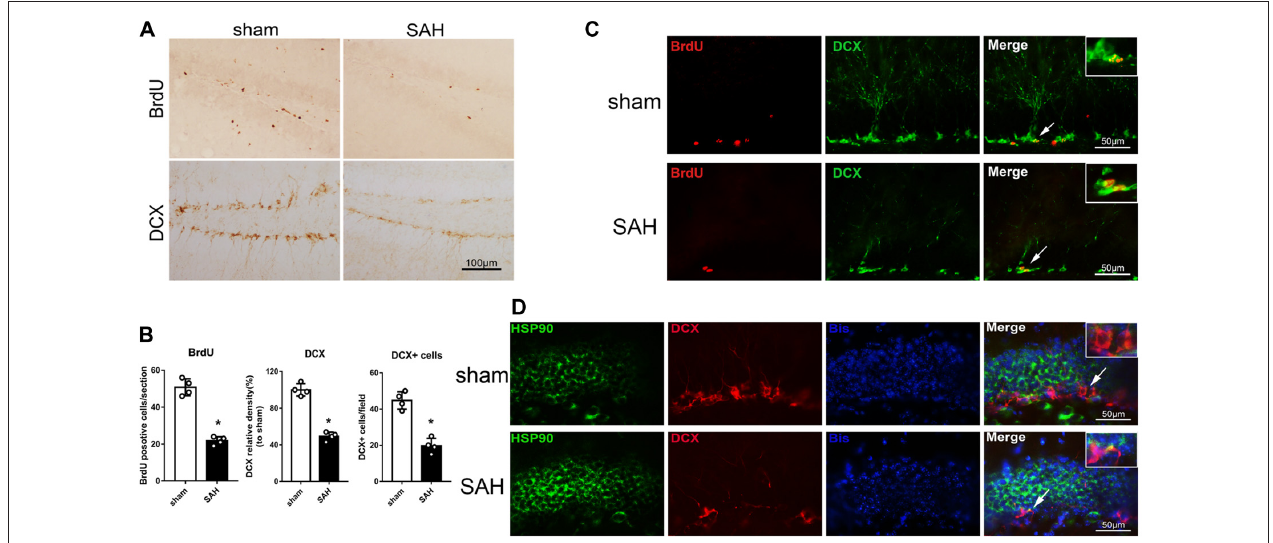
FIGURE 2 | Expression of doublecortin (DCX) and 5-bromo-2’-deoxyuridine (BrdU) incorporation after SAH. (A) Immunohistochemistry staining and (B) quantitative analyses of BrdU and DCX in the left hippocampus in sham and SAH groups at 48 h. (C) Double immunofluorescence staining for BrdU (red) and DCX (green) in the left hippocampus 48 h after surgery. (D) Double immunofluorescence staining for HSP90 (green) and DCX (red) in the left hippocampus at 48 h after surgery; n = 4 per group. ∗ P < 0.05 vs. sham group. The error bars represent SD.